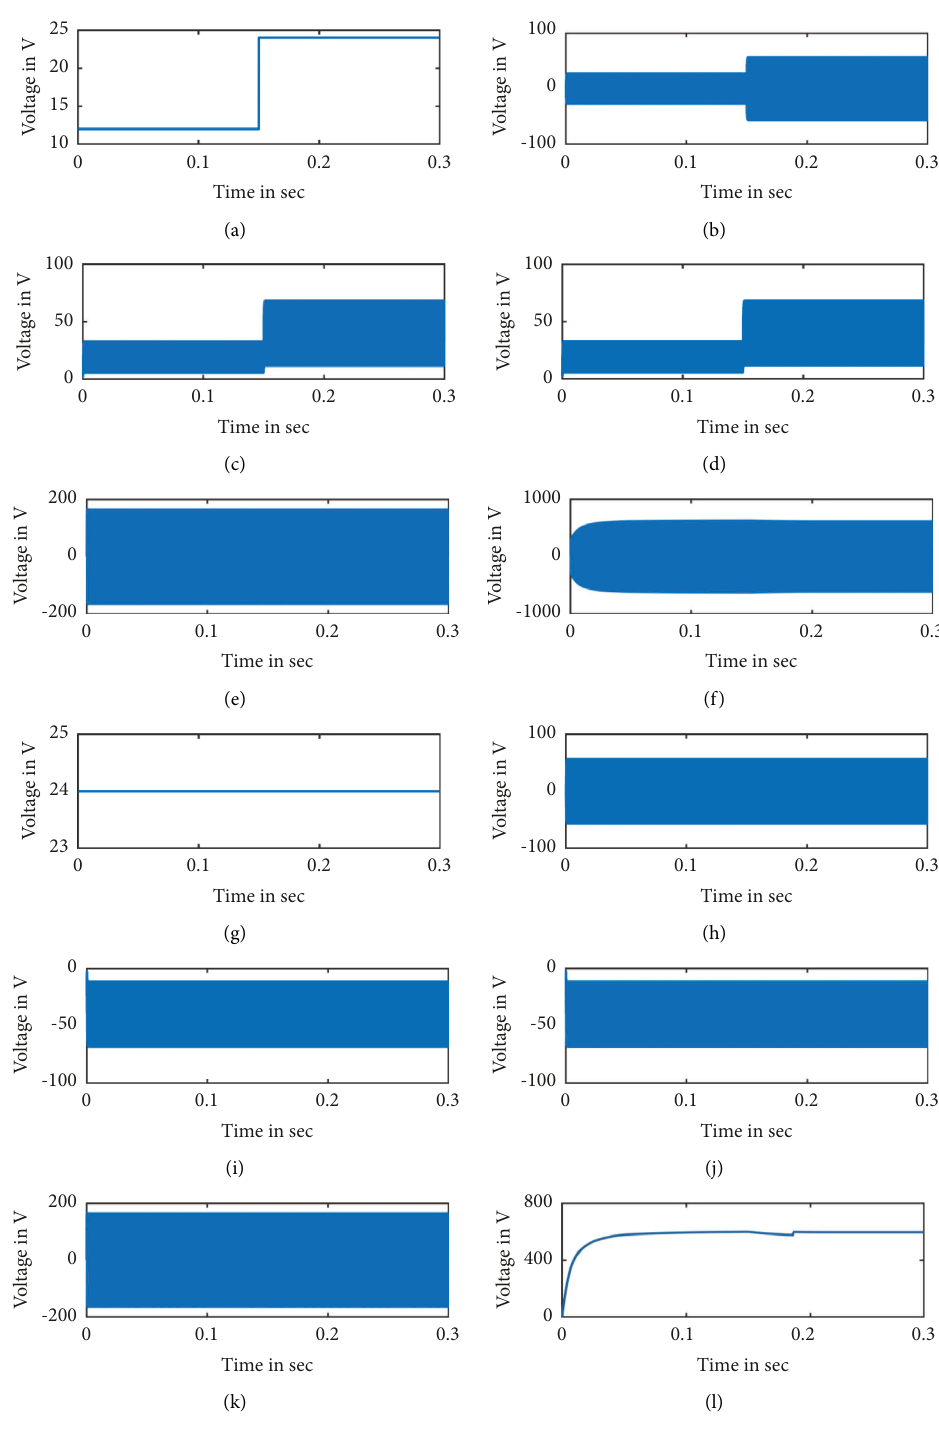
Figure 17: Simulation results of the proposed MMPIFC boost converter for investigation 2. (a) PV array 1 voltage. (b) voltage across the input inductor LA. (c) Voltage across capacitor CA1. (d) Voltage across capacitor CA2. (e) Primary 1 voltage HF transformer. (f) Secondary voltage of HF transformer. (g) PV array 2 voltage. (h) Voltage across the input inductor LB. (i) Voltage across capacitor CB1. (j) Voltage across capacitor CB2. (k) Primary 2 voltage HF transformer. (l) DC bus